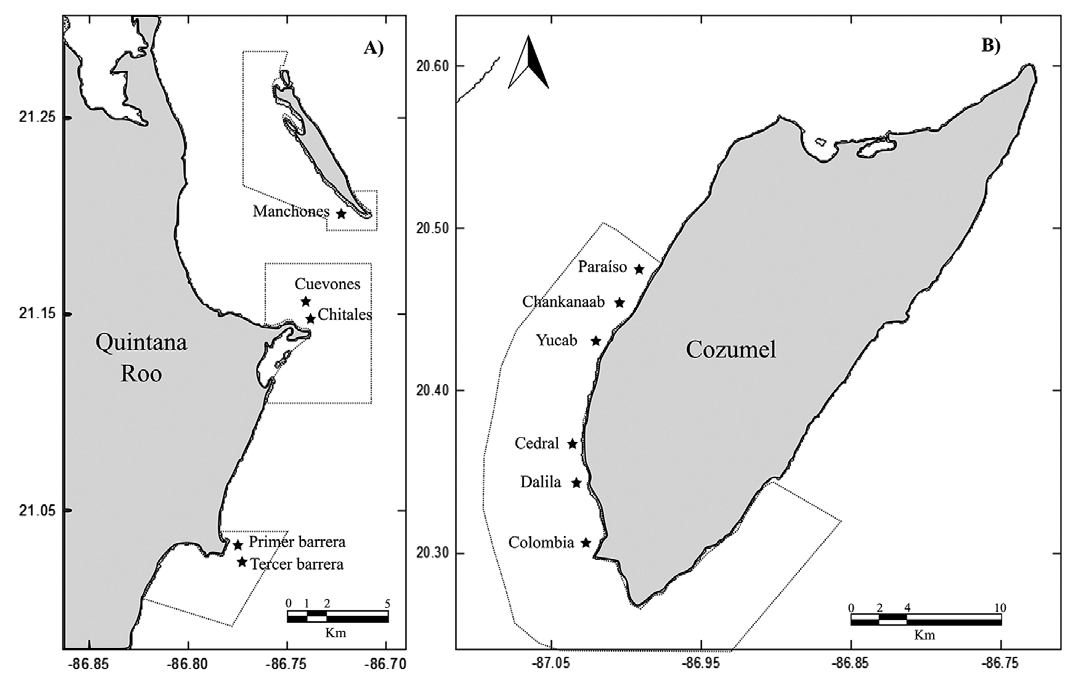
Fig. 1. – Study area. A, Yucatan Peninsula; B, Cozumel Island. The continuous line delimits the polygons of Cancún National Park and Cozumel National Park. The dots represent the sampled